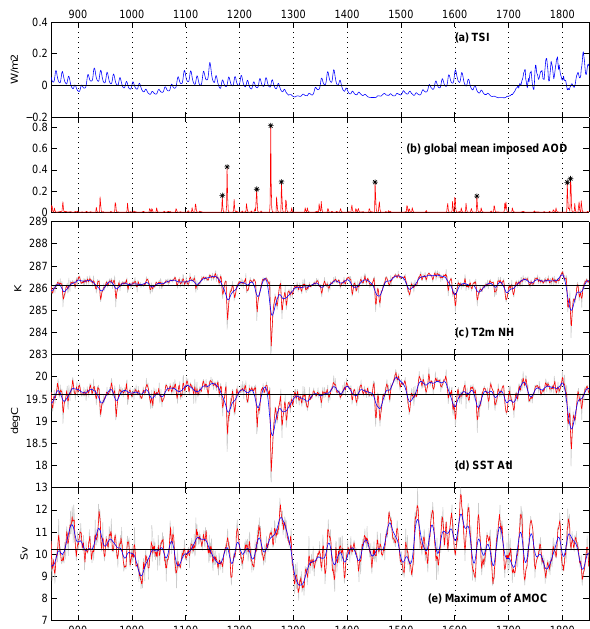
Fig. 2. Time series from 850 to 1850 of (a) Anomalous short wave input at the top of the atmosphere, taken as an estimation of vari- ations of the TSI, (b) Imposed optical depth of volcanic aerosols. (c) Northern Hemisphere air temperature at 2m (d) SST averaged between 30 ◦ S and 70 ◦ N in the Atlantic (e) . Maximum of the merid- ional overturning circulation between 10 ◦ N and 60 ◦ N and below 500m depth in the Atlantic. For c, d, and e , raw annual mean data are shown in grey and low pass filtered data using a running mean of 3 years in red. Low pass filtered data using a spline function with a cutoff at 20 years are shown in